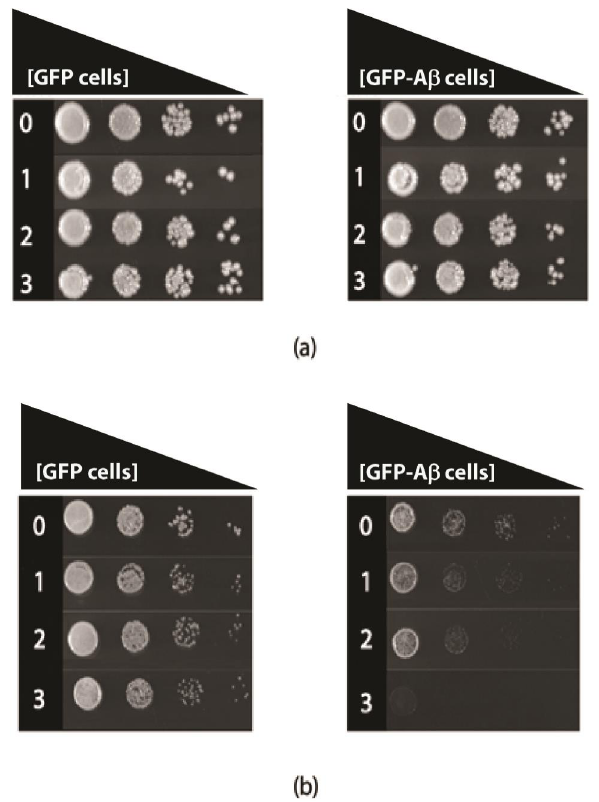
Figure 4. Growth of S. cerevisiae BY4743 (p416GPD.GFP) and BY4743 ( p416GPD.GFP.Aβ ) transformants on ( a ) Yeast extract peptone dextrose and ( b ) Yeast extract peptone ethanol media in the presence of 0, 1, 2 and 3 mM tyramine incubated at 30°C for 3 – 5 days.